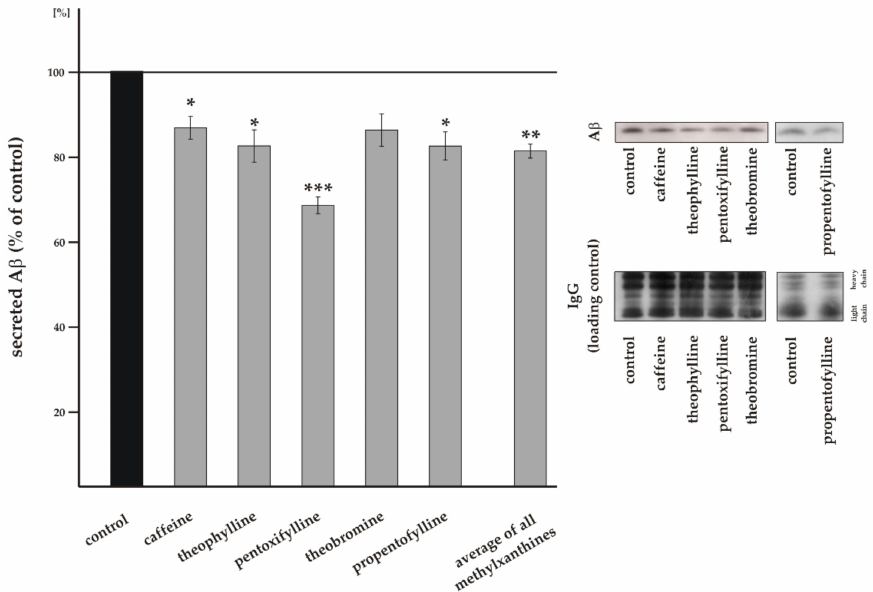
Figure 2. E ff ect of MTXs on A β generation. Level of total secreted A β in the medium of treated SH-SY5Y amyloid precursor protein (APP) 695 cells. Treatment with ddH 2 O as solvent control was set to 100%. Representative A β signals after immunodetection and the corresponding IgG signals as loading control are shown on the right side of the figure. Error bars represent the standard error of the mean. Asterisks show the statistical significance calculated by unpaired Student’s t test (* p ≤ 0.05; ** p ≤ 0.01; *** p ≤ 0.001). No significant di ff erences were found between the e ff ect strengths of the analyzed MTXs using ANOVA